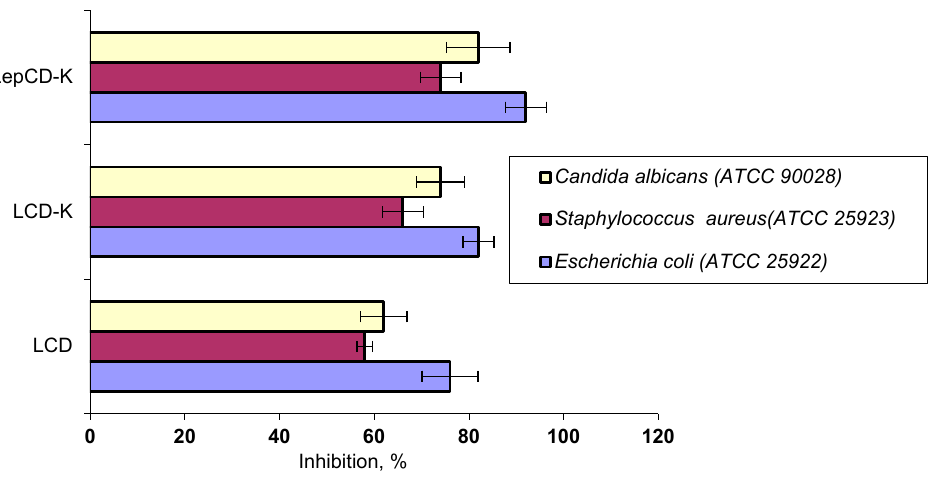
Figure 5. Antimicrobial activity of tested materials. Table 5. Antioxidant activity of